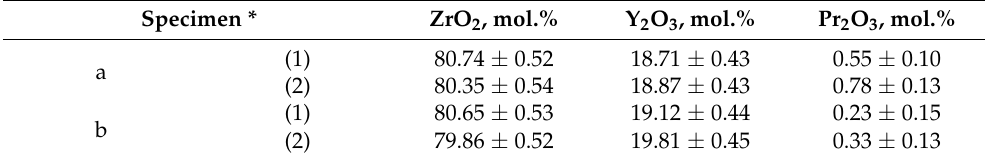
Table 1. Elemental analysis data for test crystals. Specimen * ZrO 2 ,